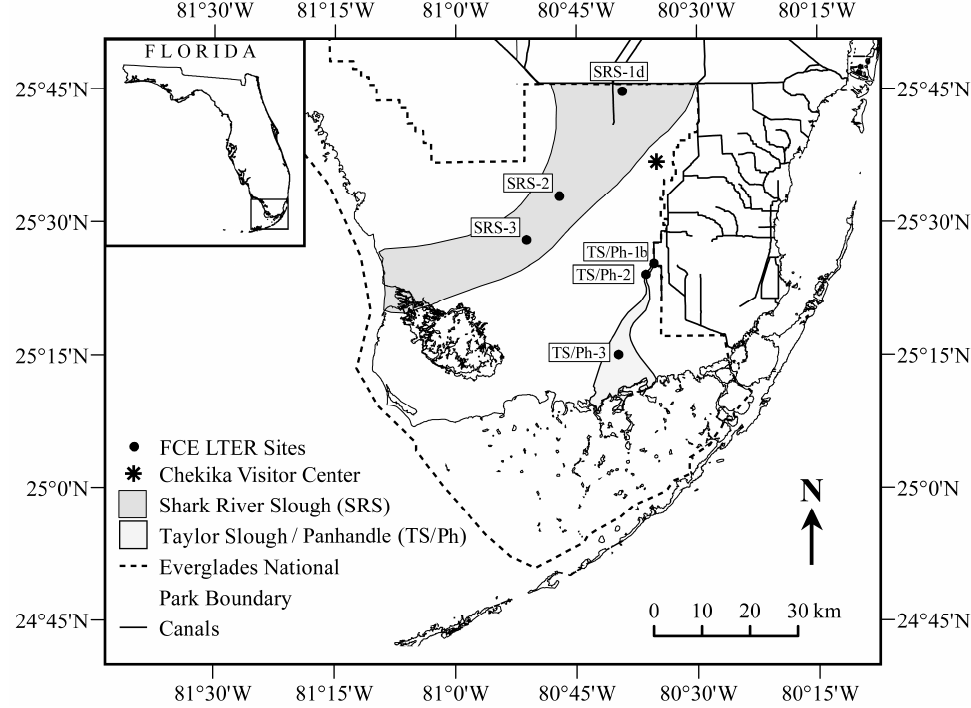
Figure 1. Map of the Florida Coastal Everglades Long Term Ecological Program sampling sites.